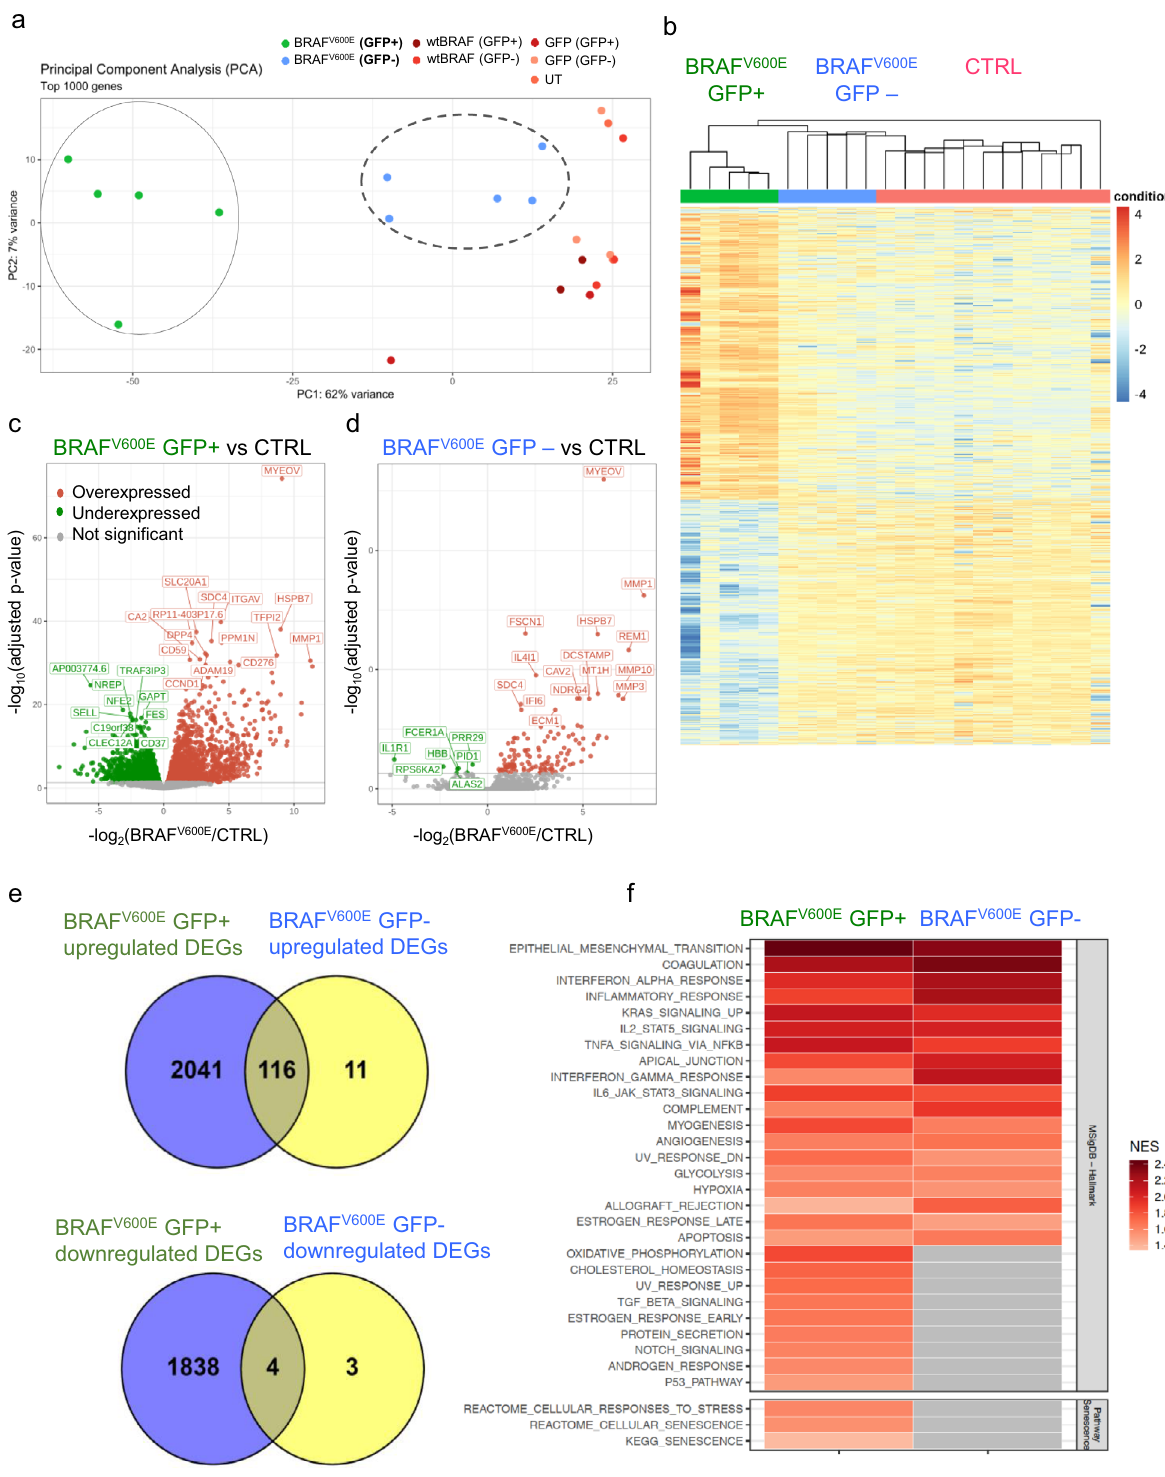
megakaryocyte/erythrocyte progenitors (MEP), followed by the HSC-enriched fraction (CD90 + ), erythroid progenitors (EP), common-myeloid progenitors (CMP), and multi-potent progeni- tors (MPP) with marking levels ranging from 15 to 30%, while multi-lymphoid progenitors (MLP) and B and NK cell progeni- tors (PreBNK) had less than 5% marking (Supplementary Fig. 3c). Of note, transduction levels across hematopoietic subsets did not vary signi fi cantly between the wtBRAF and BRAF V600E